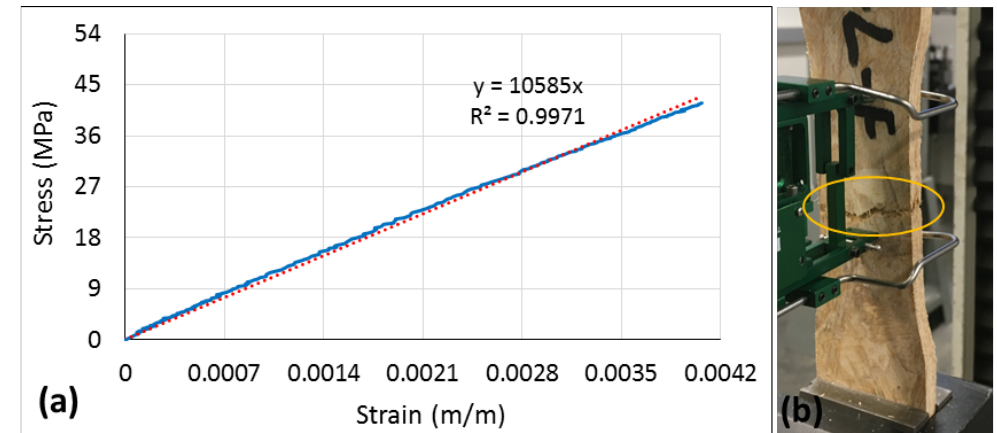
Figure 6. Typical results of tensile testing: ( a ) load–strain graph (blue line) along with regression model (red dotted line), ( b ) failure mode.